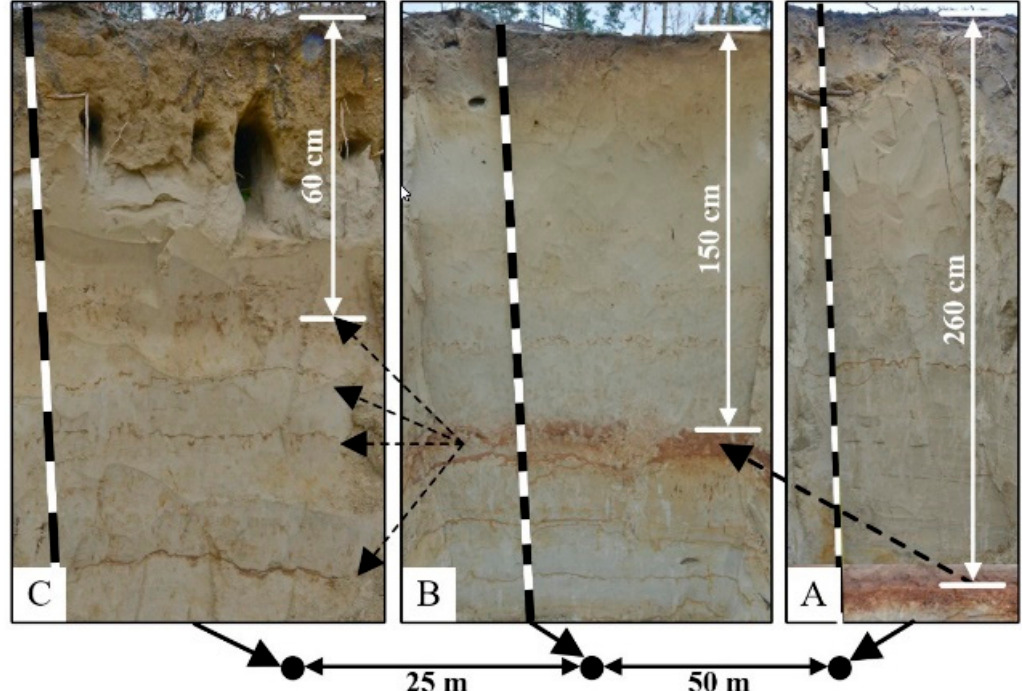
Figure 9. Transformation of Paleosol 2 into a series of lamellaes along the slope: ( A ) studied section with paleosol located at a depth of 260 cm; ( B ) appearance of the same paleosol at a depth of 150 cm in the elevated position along the slope; ( C ) series of lamellae at a depth of 60 cm in the most elevated